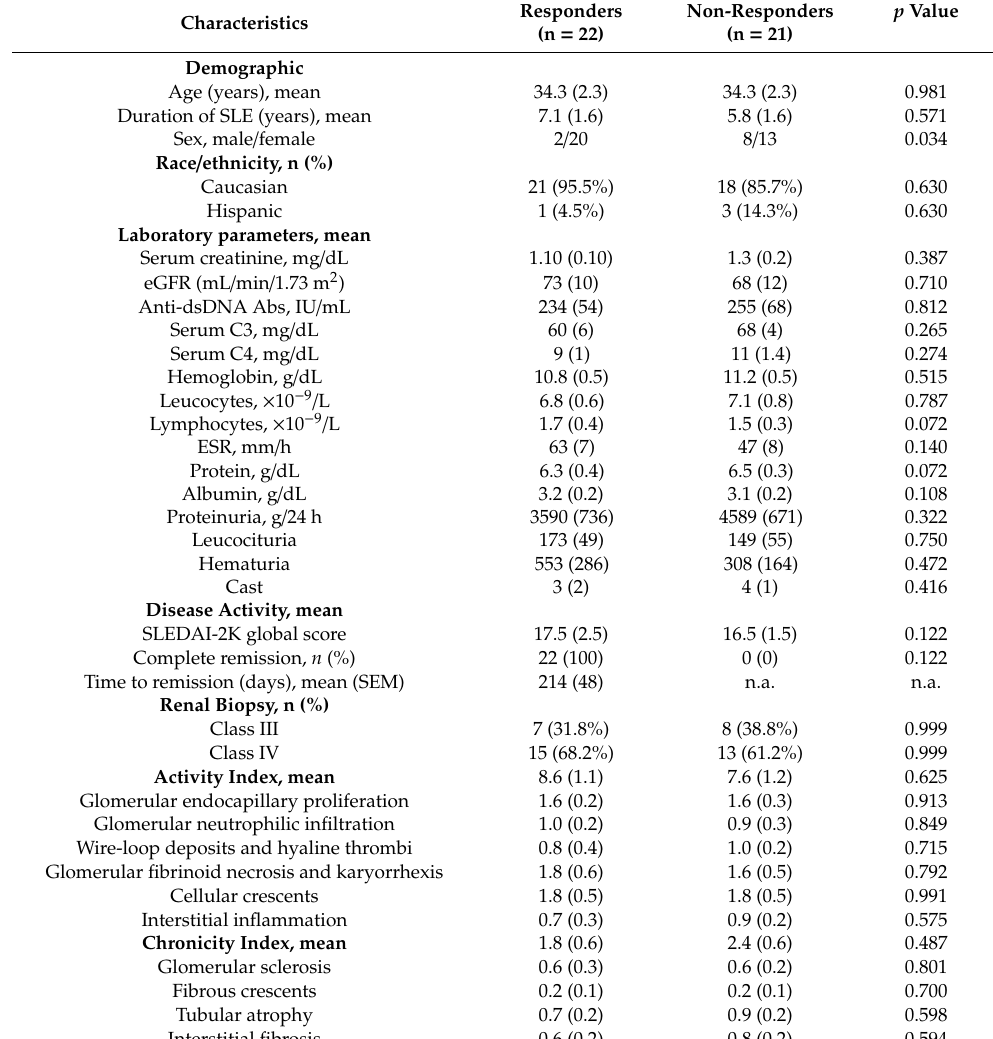
Table 2. Baseline demographic, laboratory, and clinical data according to clinical response from the second